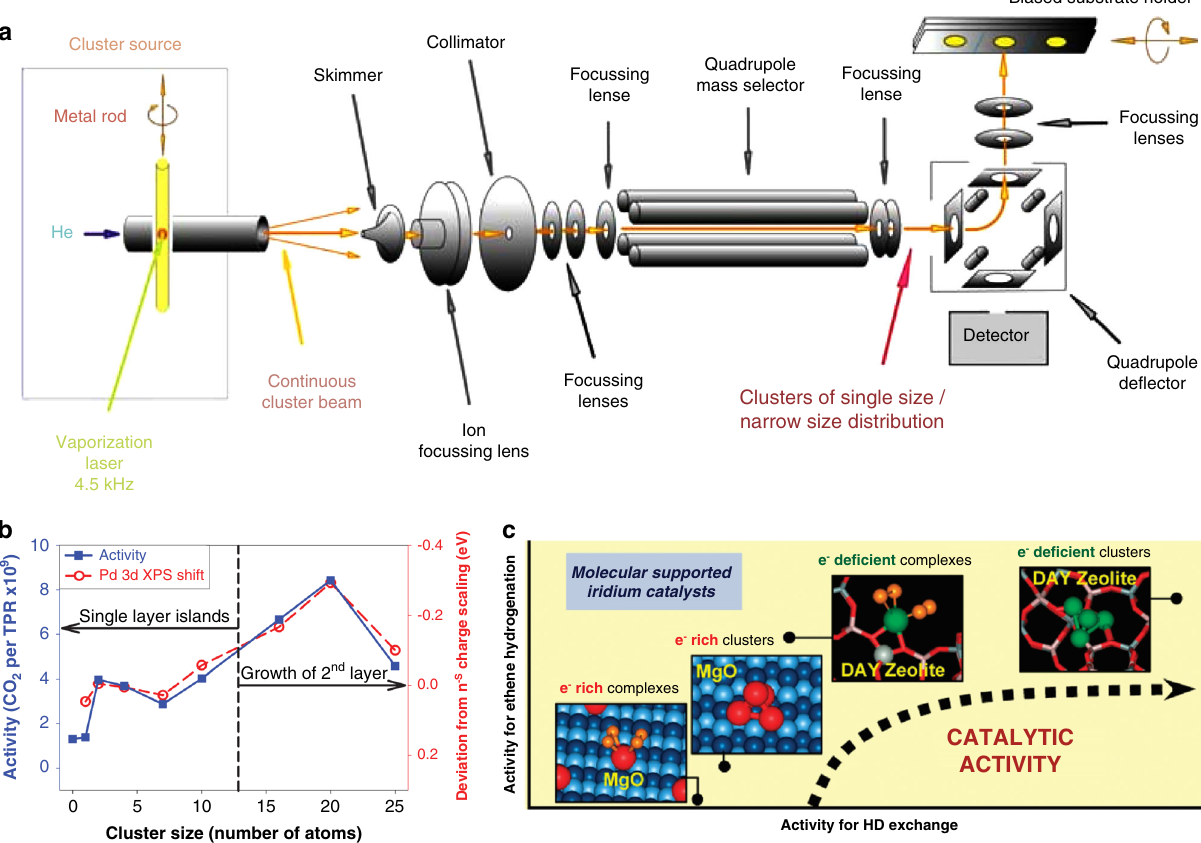
Fig. 3 The size-selected strategy. a Schematic of the cluster deposition setup, reprinted with permission from Springer Science + Business Media, Inc.: Springer Nature, Topics in Catalysis , ref. 44 (Winans et al.). Copyright (2006). b CO oxidation activity observed during the temperature-programmed reaction (left axis, solid squares) compared with shifts in the Pd 3d binding energy, relative to expectations from smooth bulk scaling (right axis, open circles), as a function of cluster size. From ref. 7 . Reprinted with permission from the American Association for the Advancement of Science (AAAS). c Schematic illustration of mononuclear Ir and Ir 4 clusters supported on MgO and dealuminated HY zeolite. Their relative catalytic activities for ethane hydrogenation are also presented, reprinted with permission from ref. 71 . Copyright (2011) American Chemical